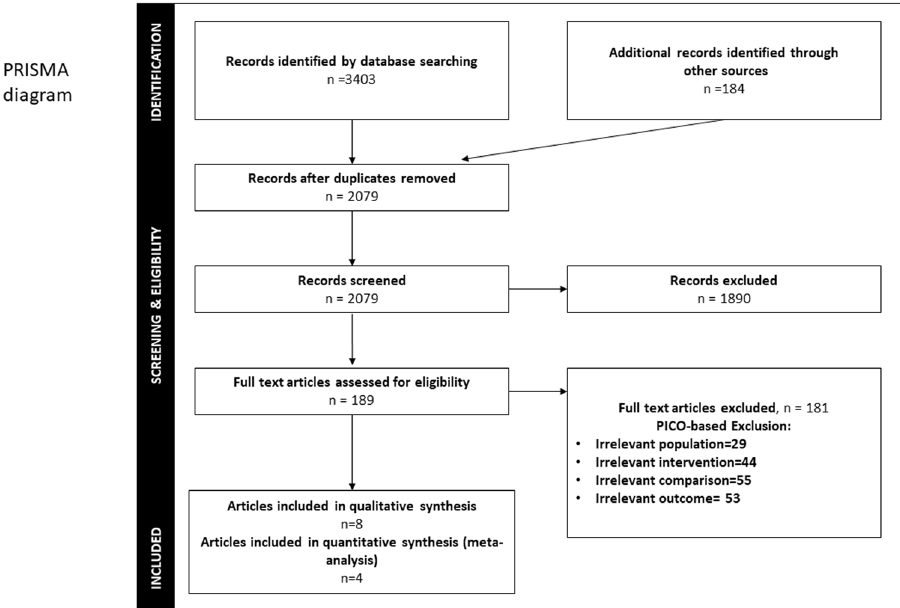
Fig. 1 PRISMA fl ow diagram of literature search strategy: including identi fi cation, screening, eligibility examination, and fi nal inclusion. The number of records identi fi ed during the initial search represents the sum of all papers collected through each electronic